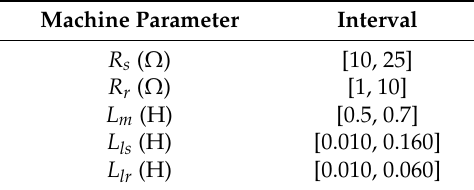
Table 3. Parameter ranges for the PSO variables.